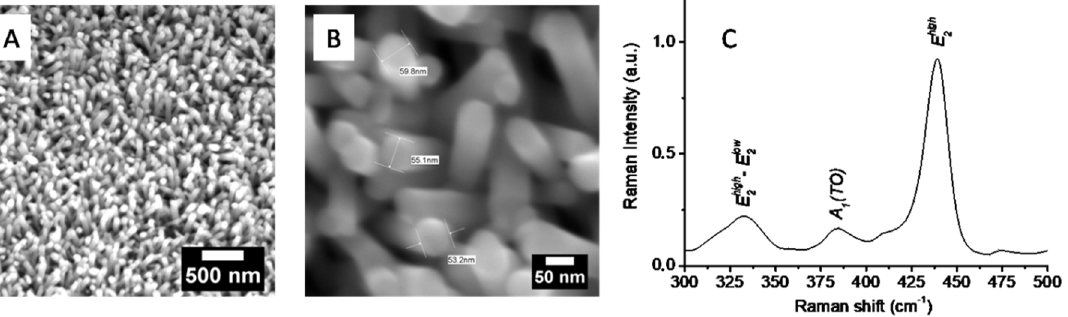
Figure 2. ( A ) SEM, ( B ) high-resolution SEM images, and ( C ) Raman spectrum for as-prepared ZnO NRs.